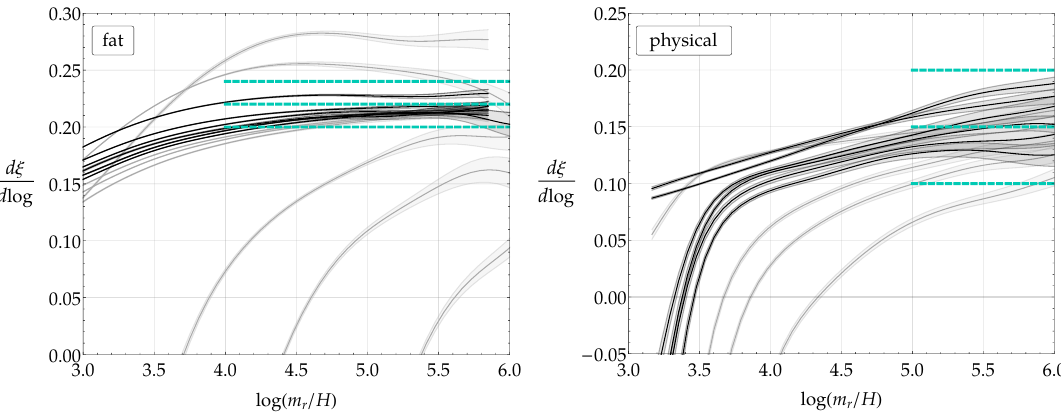
Figure 25 . The derivative d(cid:24)=d log( m r =H ) for di(cid:11)erent initial conditions. The black curves are approximately constant for the largest amount of time and therefore the closest to scaling, and their spread is used to estimate the error on (cid:11) . Blue dashed lines represent the estimate of (cid:11) , and are plotted at times when the system is reasonably close to scaling. Error bands represent statistical errors in the average over di(cid:11)erent